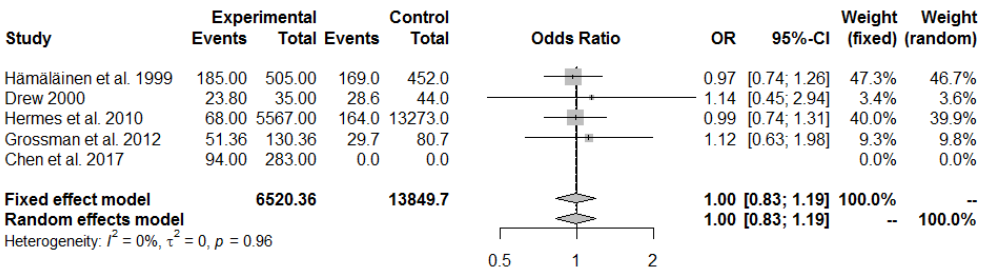
6 of 12 Figure 3. Pulled ORs of pain in the neck spine in fighter pilots vs. transport pilots. Study shows first author and year of publication; [3,27,29,31,33].